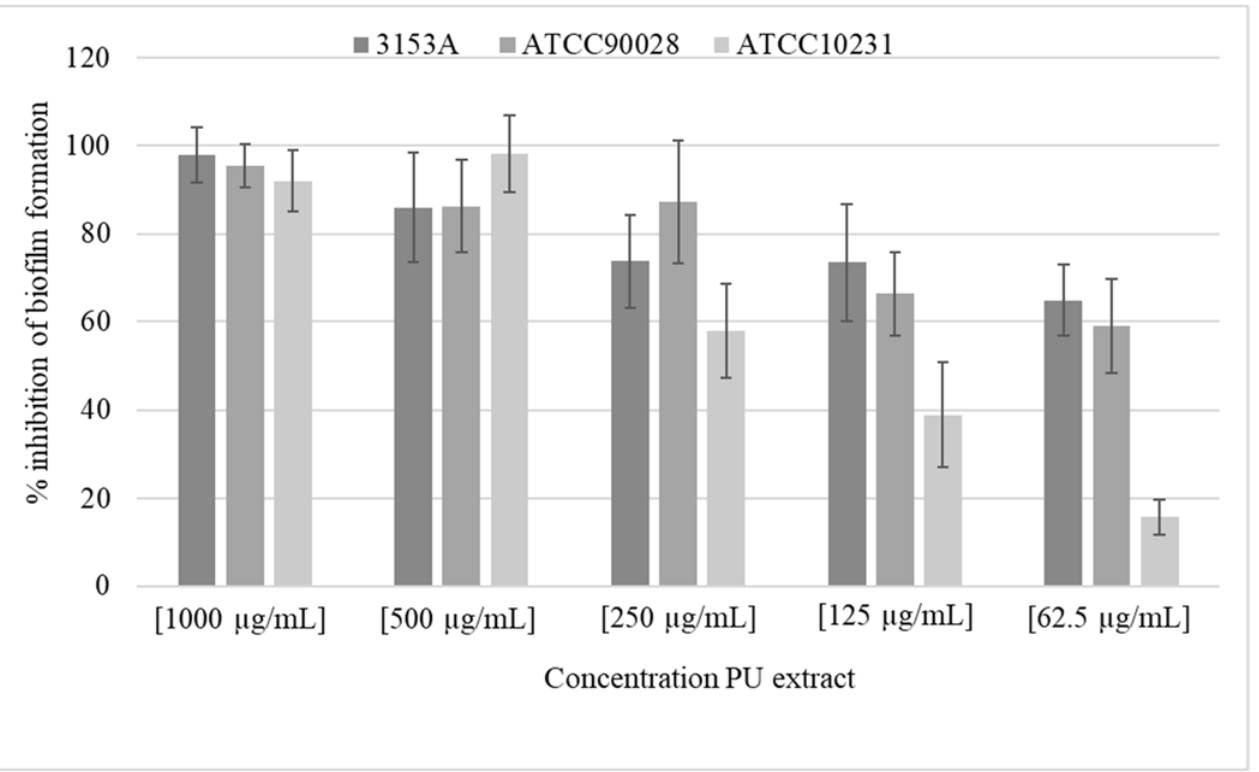
Figure 1. Inhibition of C. albicans biofilm formation using PU sample.